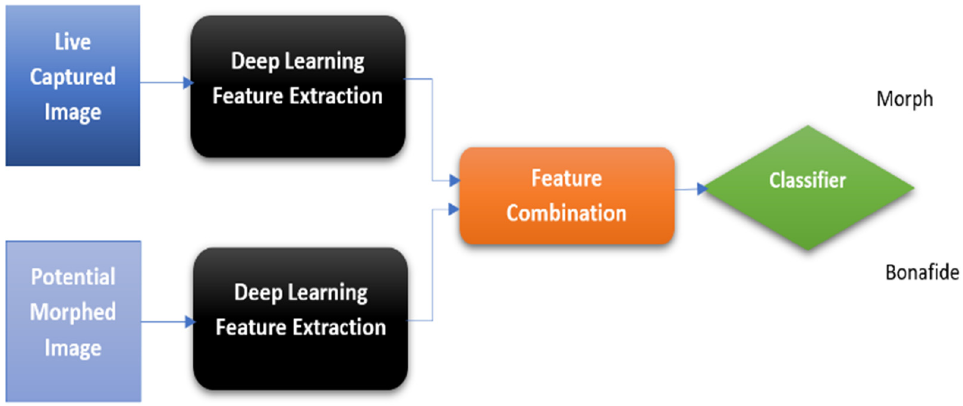
Figure 4. Basic methodology of a differential morph attack detection model.